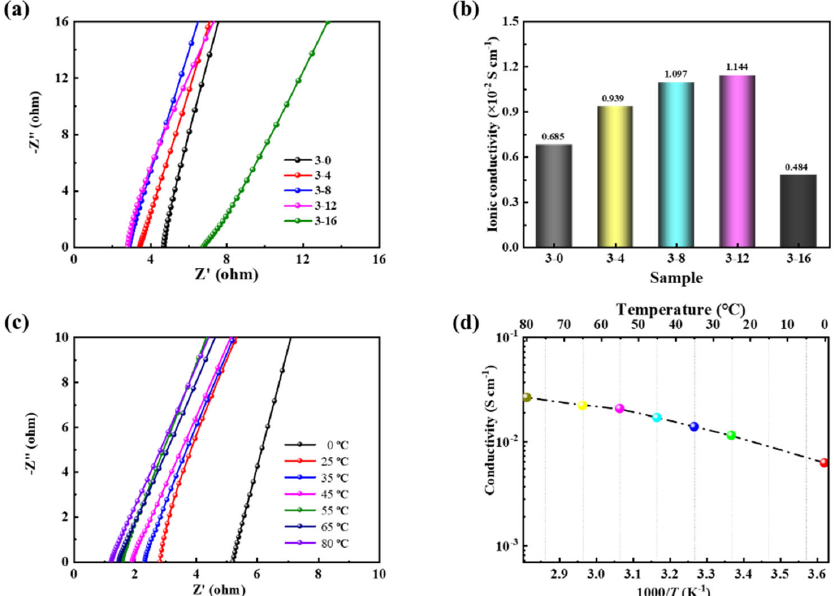
Figure 4. ( a ) AC impedance spectra and ( b ) ionic conductivity of GPE; ( c ) AC impedance spectra and ( d ) ionic conductivity of GPE in different temperatures.